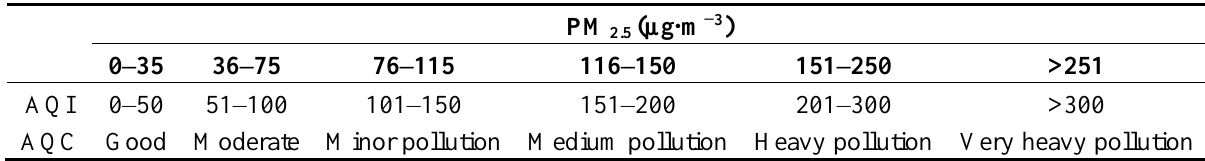
Table 1. Twenty-four hourly mean PM 2.5 (µg ∙ m −3 ) and its corresponding Air Quality Index (AQI) and Air Quality Category (AQC) by